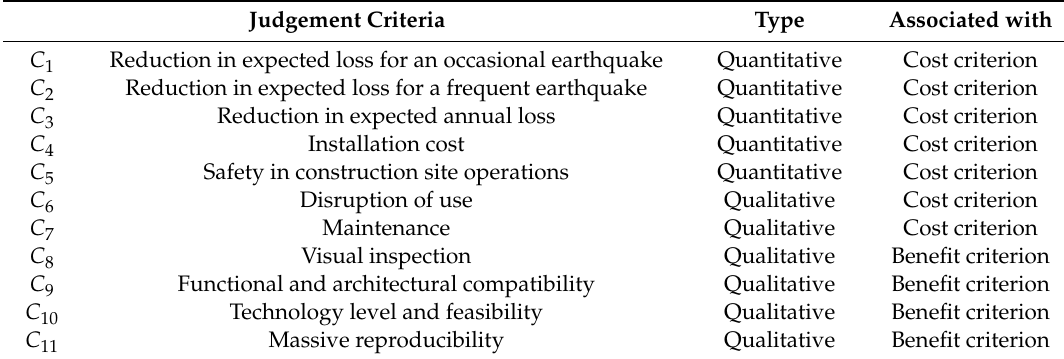
Table 1. Judgement Criteria to Select the Optimal Retrofitting